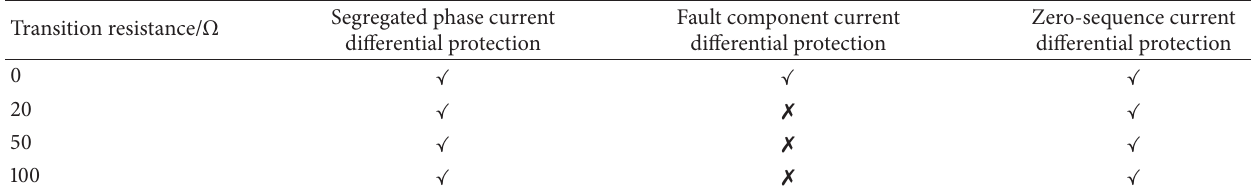
Table 4: Operation of current differential protection on the different ground fault situation at the fault point